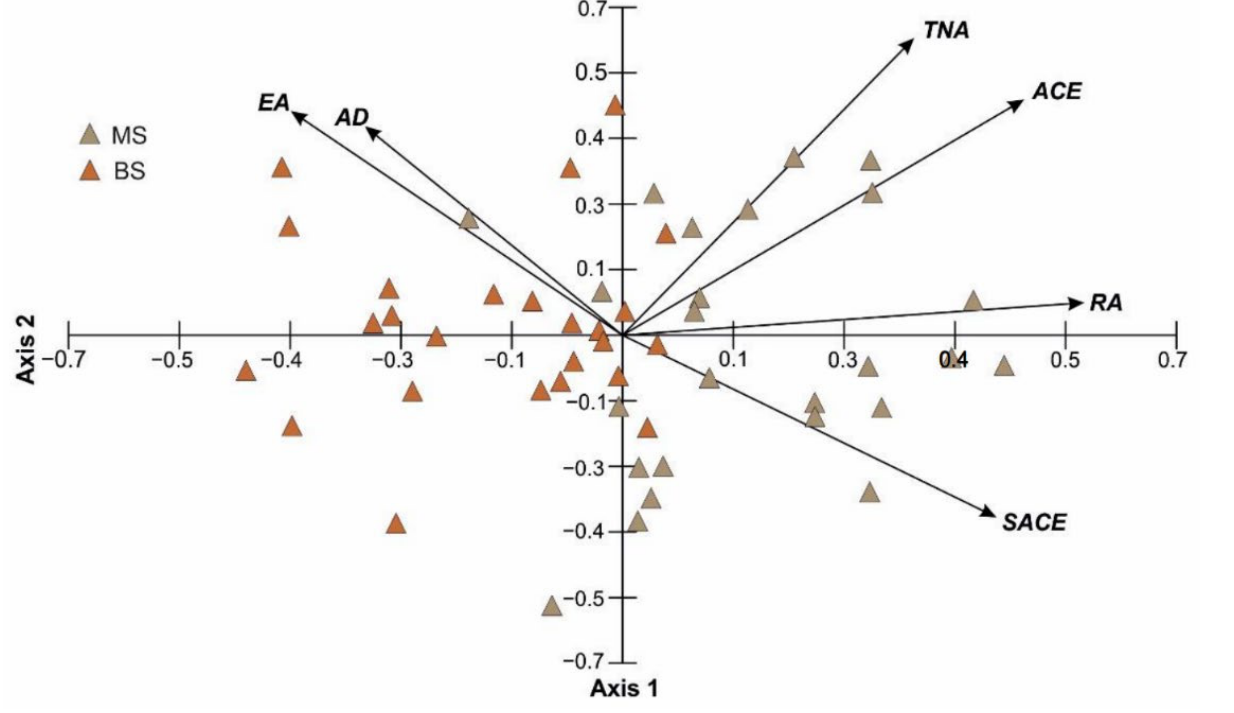
Figure 4. Results of PCA based on the characteristics of infructescences from the main stem and infructescences from the branch stem. MS—main stem; BS—branch stem; TNA—total number of achenes; ACE—number of achenes containing a developed embryo; EA—number of empty achenes; SACE—percent share of achenes containing a developed embryo; RA—receptacle area; AD—achene density.